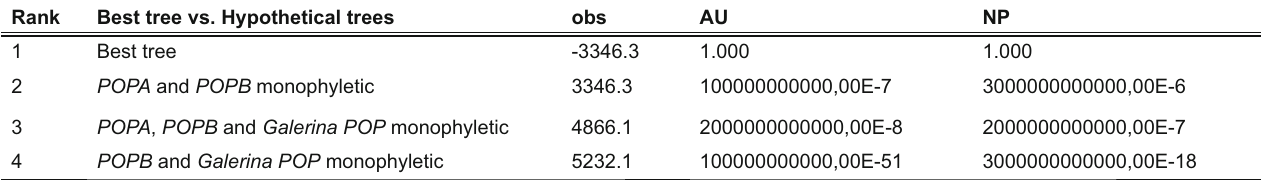
Table 5. Approximately unbiased test on alternative POP trees. Best tree vs. Hypothetical trees